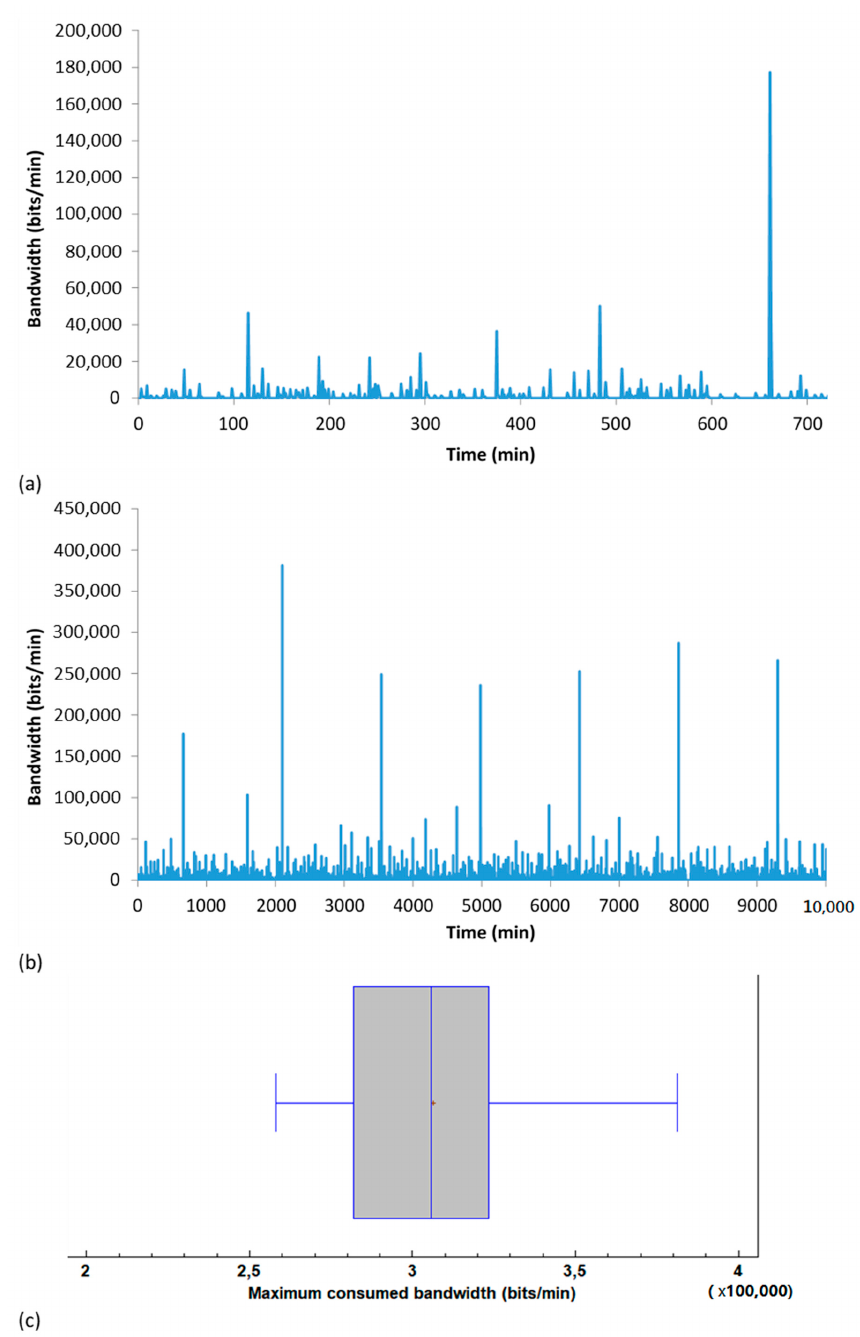
Figure 14. Details of consumed bandwidth in our simulation. Different letters denote different details: ( a ) initial period, ( b ) whole period, ( c ) summary of the maximum bandwidth of 40